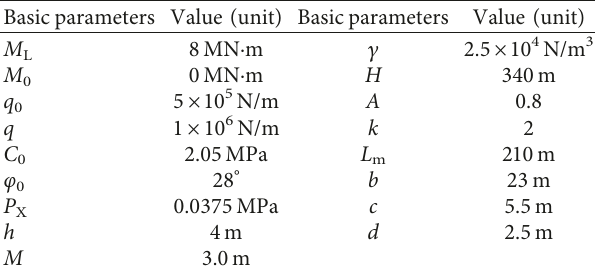
Table 1: The basic parameters of the No. 18205 working face. Basic parameters Value (unit) Basic parameters Value